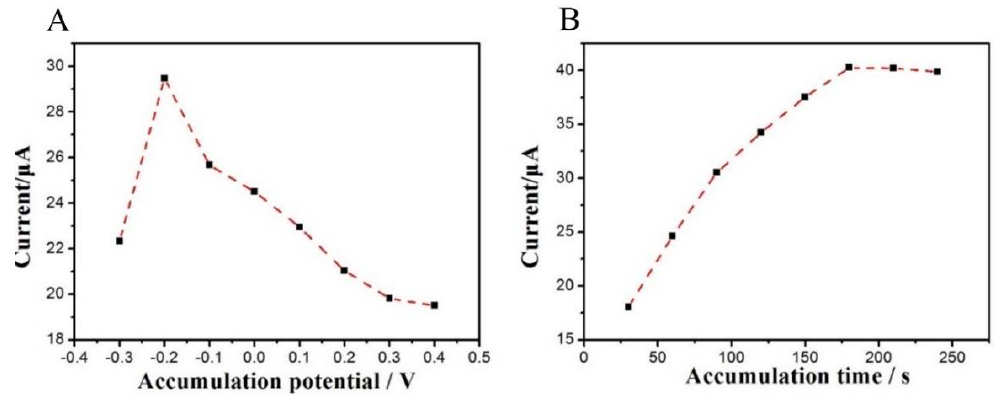
Figure 5. Effects of accumulation potential ( A ) and accumulation time ( B ) on the oxidation peak currents of 1.0 × 10 −5 mol/L Tartrazine at TiO 2 –ErGO–GCE.